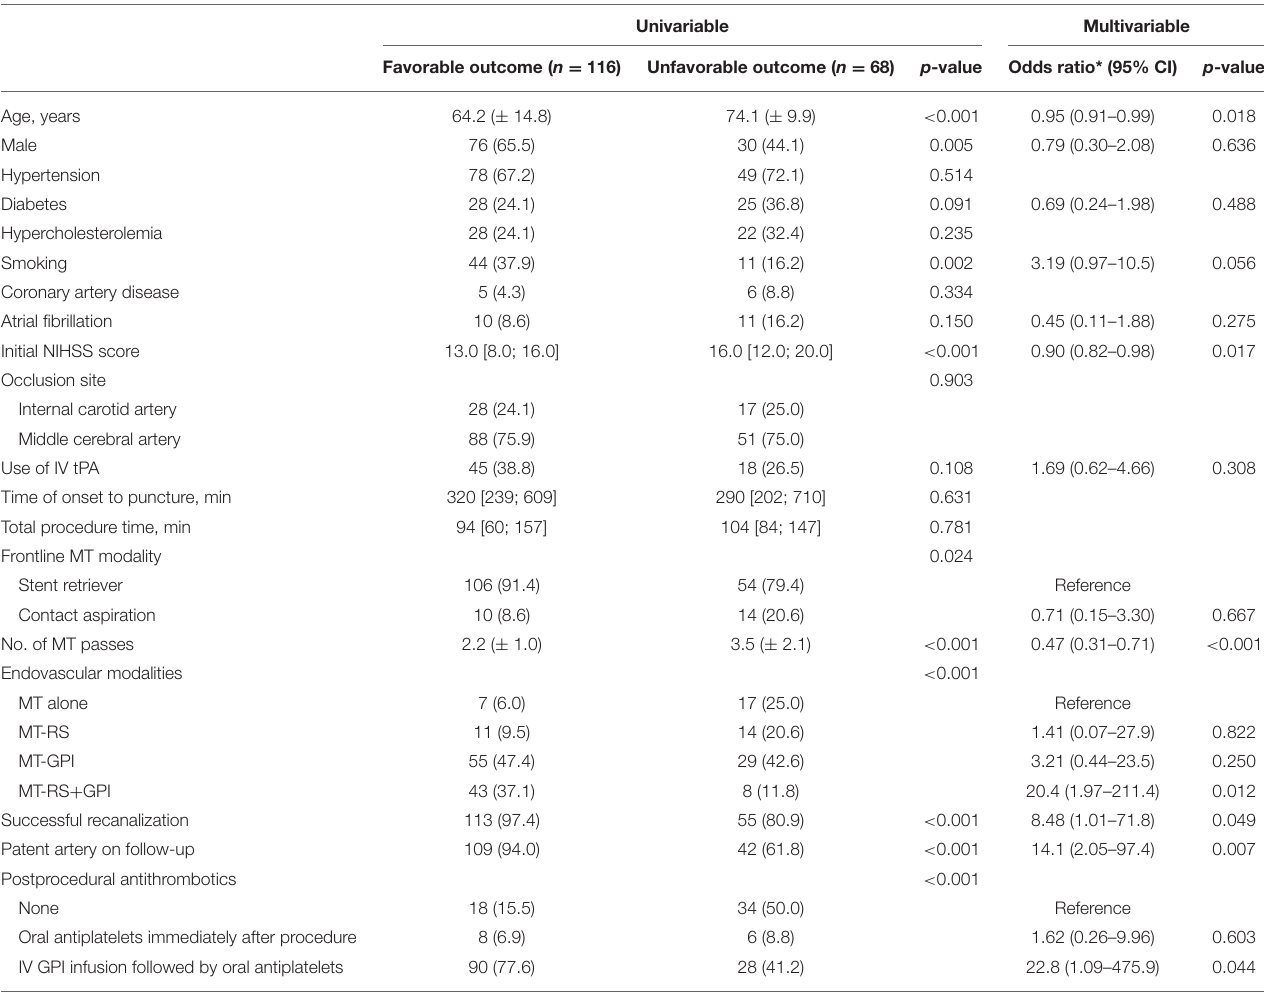
TABLE 2 | Factors associated with favorable